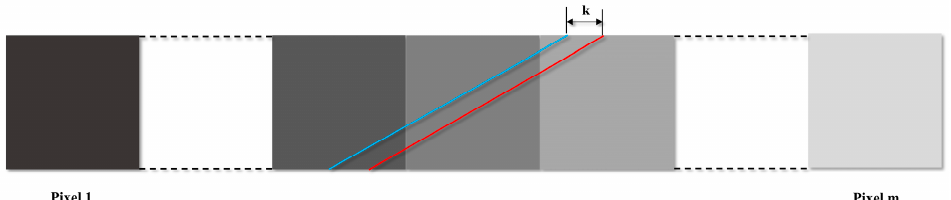
Figure 5. The subpixel edges (represented by red and blue) under two adjacent bands in a row of the abundance map.